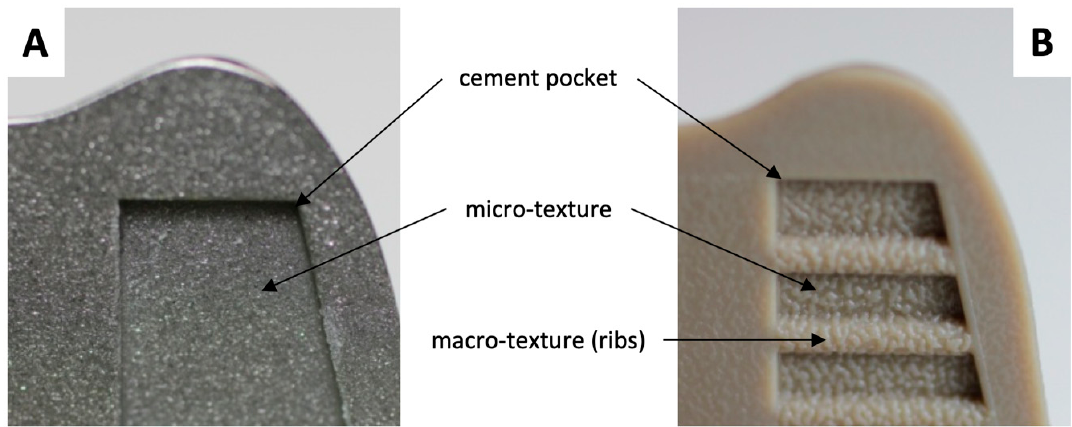
Figure 1. Surface texture of the CoCr ( A ) and PEEK ( B ) implants. The additional cement-bonding features of the PEEK implant are visible, comprising a macroscopic rib features within the cement pockets and a microscopic pattern superimposed over the surface. Adapted from de Ruiter et al. (2017) [26].